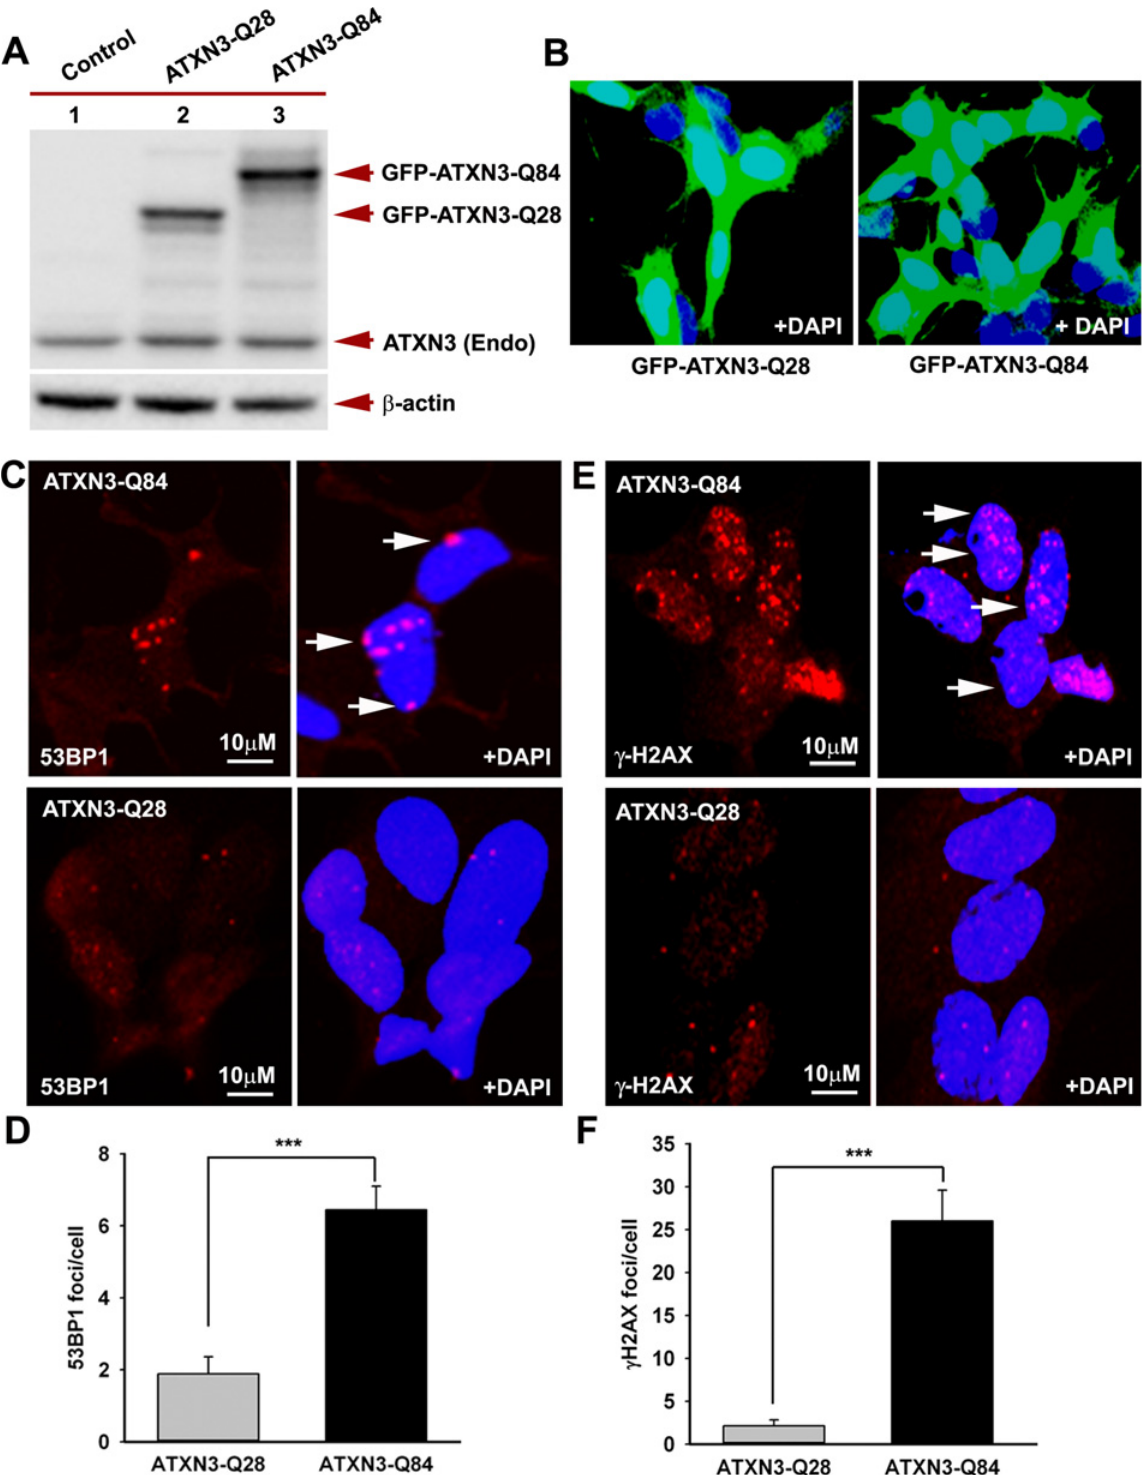
Figure 3. Expression of mutant ATXN3 in cells induces DNA strand breaks. (A) Expression of GFP-ATXN3-Q84 and GFP-ATXN3-Q28 was induced in SH-SY5Y cells; 48 hours after induction, the cells were harvested and their lysates analyzed by Western blotting with anti-ATXN3 monoclonal antibody to detect endogenous ATXN3 and exogenous GFP-ATXN3-Q28 and GFP-ATXN3-Q84 levels (shown by arrows). Lane 1, control SH-SY5Y cells; lane 2, SH- SY5Y cells expressing GFP-ATXN3-Q28; lane 3, SH-SY5Y cells expressing ATXN3-Q84; β -actin was used as loading control. (B) Confocal images